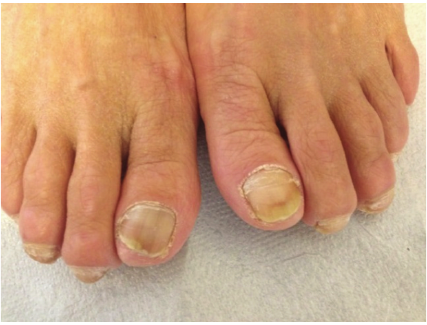
Figure 1: Discoloration and onycholysis image in bilateral toenail.